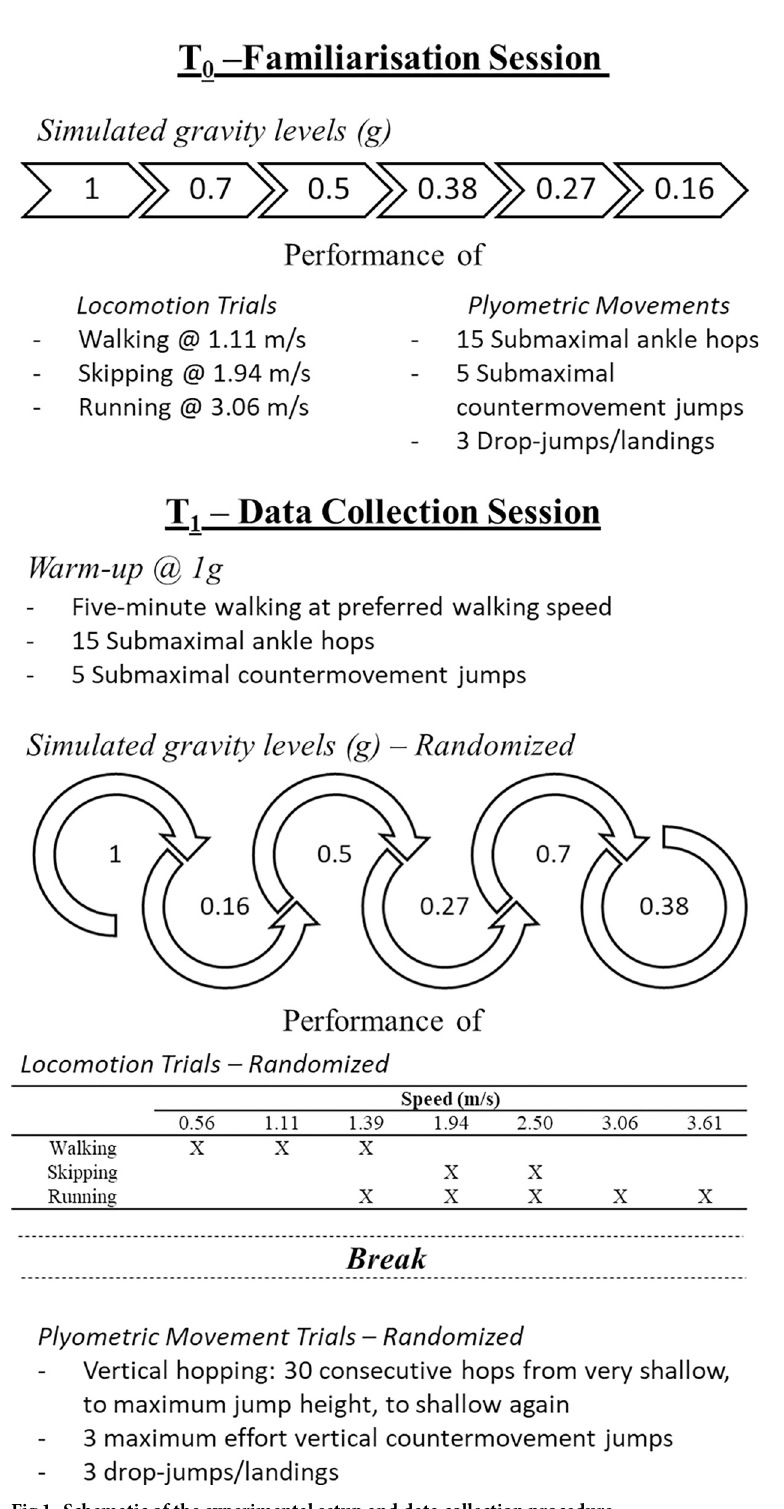
Fig 1. Schematic of the experimental setup and data collection procedure.